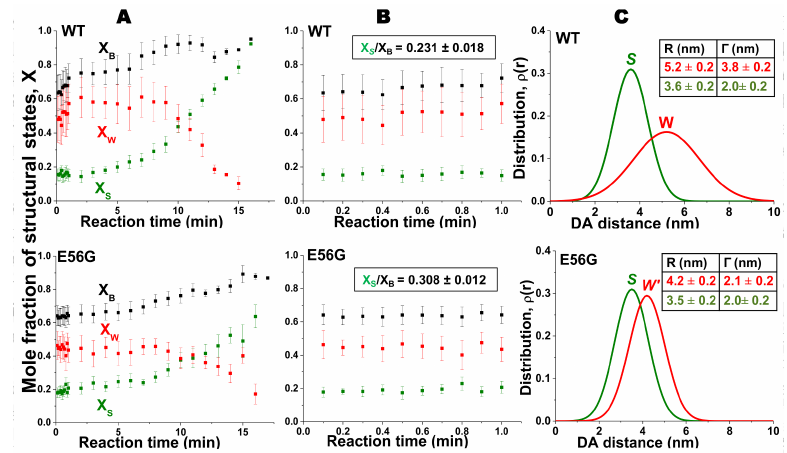
Figure 4. Structural states of actomyosin complex affected by a cardiomyopathy mutation as detected by TR-FRET. ( A ) Time dependence of FRET-detected mole fractions (X) of structural states after addition of ATP to a mixture of donor-labeled actin and acceptor-labeled myosin S1 (WT, top and E56G, bottom). X B ( (cid:4) , black) is the fraction of donor that has bound acceptor. X B = X W + X S , where X W (red) and X S (green) are the mole fractions of W and S complexes. ( B ) Time dependence of mole fractions (expanded view) in the first minute after addition of ATP, demonstrating a true steady state. Steady-state duty ratio is shown in the box. ( C ) Interprobe distance (R) and distribution ( Γ ) (best fit to a Gaussian function) corresponding to bound acto-S1 complex determined from S (green) and W (red) complexes (WT, top and E56G, bottom). While the structure (distance distribution) of the S complex is not significantly affected by the mutation, the W complex is shifted to a shorter distance and a narrower width, so it is designated W (cid:48) . Each curve is normalized to the unit area, which is independent of the mole fraction X S or X W . Thus the distribution of actin-bound distances R at a given time after mixing is given by a linear combination ρ (R) = (X S /X B ) ρ S (R) + (X W /X B ) ρ W (R). Adapted from [27], Guhathakurta, P.;